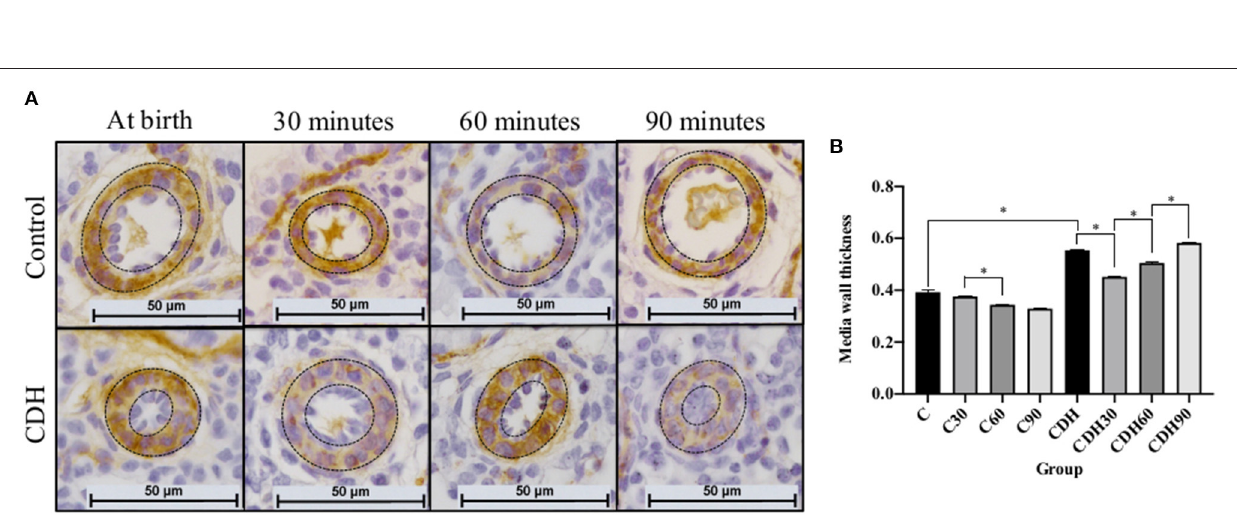
FIGURE 2 | Mechanical ventilation induces a transient improvement of the media wall thickness (MWT) of the pulmonary arteries in the CDH. (A) Photomicrographs of representative histological sections showing pulmonary arteries immunostained for smooth muscle actin (SMA). (B) MWT measurement of pulmonary arteries on immunostained sections showing increased MWT in CDH animals with improvement in ventilated animals at 30 and 60min and return to levels similar to non-ventilated CDH animals after 90min of mechanical ventilation ( n = 10 arteries measured in four animals per group). Dashed lines refer to the arteries’ media wall thickness. CDH, congenital diaphragmatic hernia. Magnification = × 400; bar = 50 µ m. C, control; C30, control ventilated for 30 mins; C60, control ventilated for 60min; C90, control ventilated for 90min; CDH, congenital diaphragmatic hernia; CDH30, CDH ventilated for 30min; CDH60, CDH ventilated for 60min; CDH90, CDH ventilated for 90